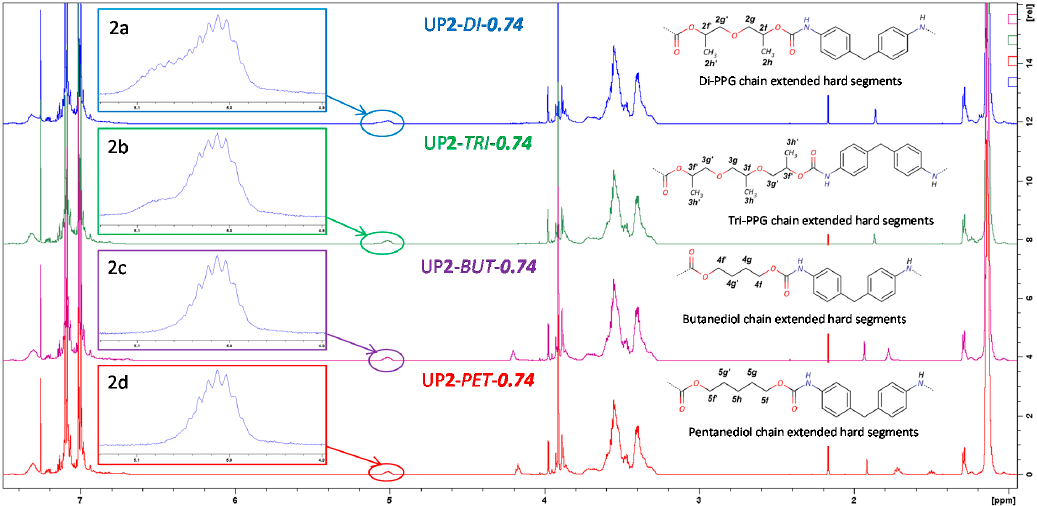
Figure 3. 1 H-NMR spectra of the chain extended samples UP 2 - DI - 0.74 , UP 2 - TRI - 0.74 , UP 2 - PEN - 0.74 and UP 2 - BUT - 0.74 , and the sketched chemical structure for the chain extended hard segments. The multiple peaks at 4.9–5.1 ppm range were enlarged and shown in Figure 3( 2a – 2d ). Table 2. Proton chemical shifts of the blank sample UP 2 - O - 0 .